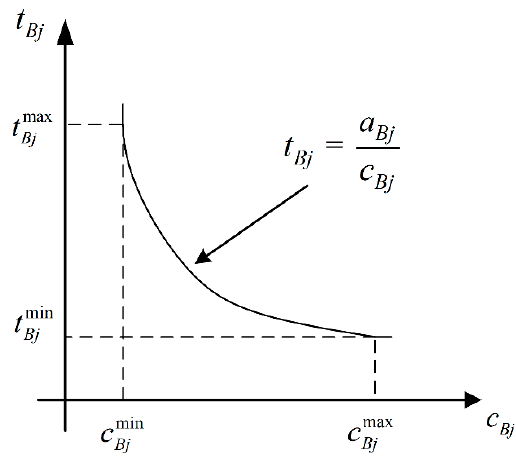
Figure 5. Relationship modeling between time and investment.